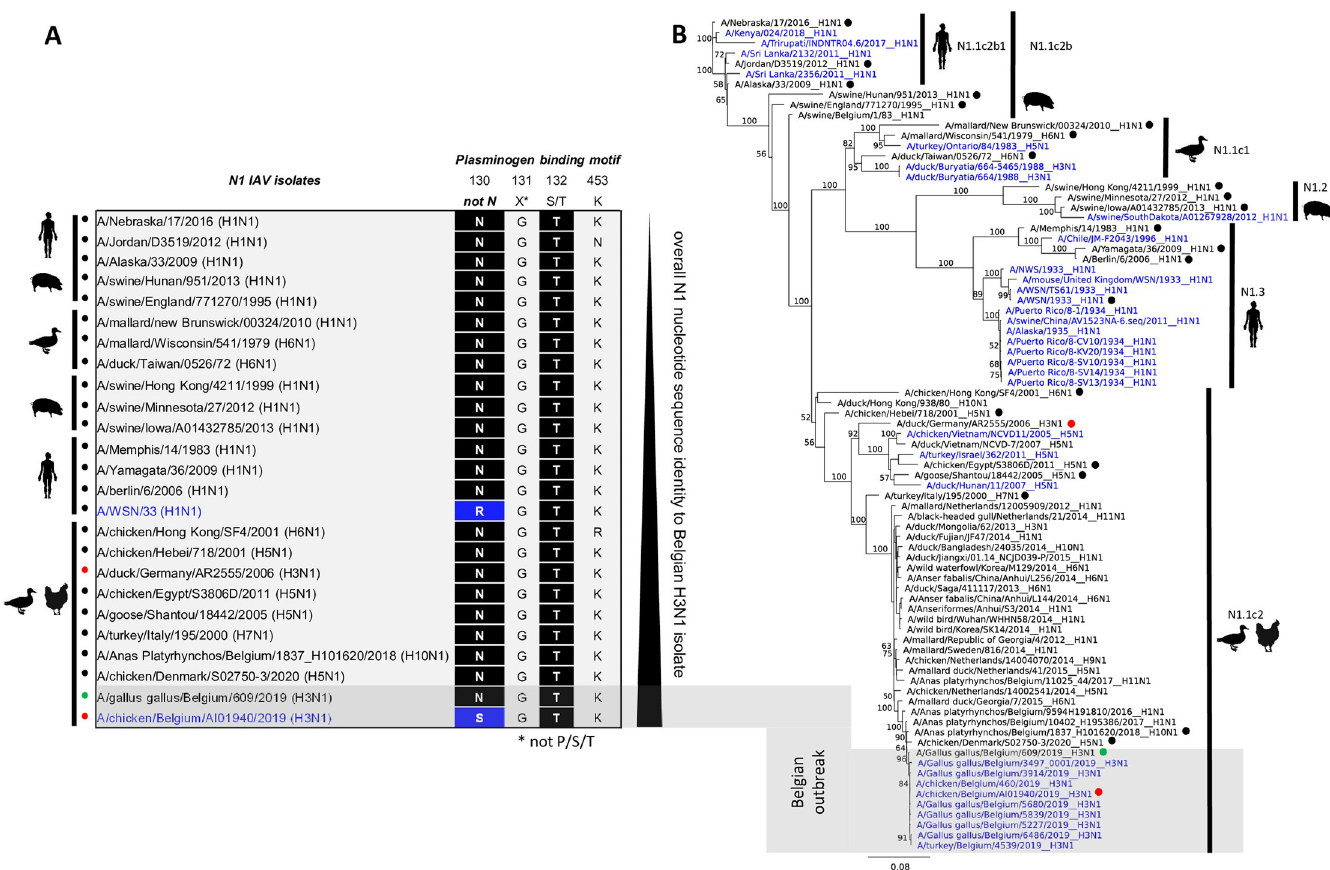
Fig 5. Sequence comparisons and phylogenetic analysis of the CK/BE/1940/19 neuraminidase (N1). (A) Amino acid alignment of positions described as responsible for neuraminidase mediated plasminogen binding. The loss of the Asn at position 130 and therefore the loss of the N-glycosylation site (blue isolate name), as described for WSN, has also been found in the CK/BE/1940/19 isolate but not in the comparative DK/DE/2555/06 isolate (red dots). First Belgian H3N1 isolate from January still has intact N-glycosylation site (green dot). Database research (www.fludb.de) including all full length N1-sequences without duplicates reveals only 24 of 11417 sequences to have no asparagine at this position. These 24 isolates (listed in detail in S2 Table ) are shown in the (B) phylogenetic tree (calculated as a maximum likelihood tree using RAxML with a bootstrap value of 1000 cycles) together with the available N1-sequences from the Belgian H3N1 outbreak (n = 9) (both blue, except the Belgian January isolate) from 2019 and other representative N1 scaffold sequences